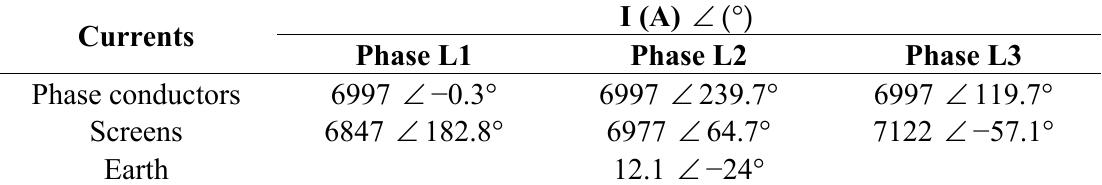
Table 1. Current distribution in the high-current busducts (screens grounded and mutually bonded on both ends and possibly additionally along the